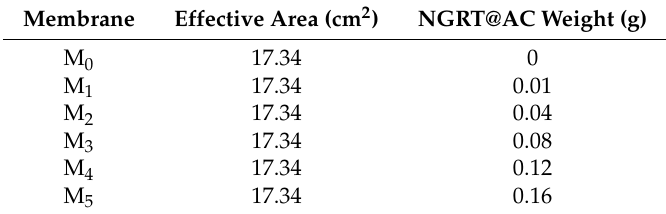
Table 1. The formulations of the composite membranes prepared by the surface deposition method.